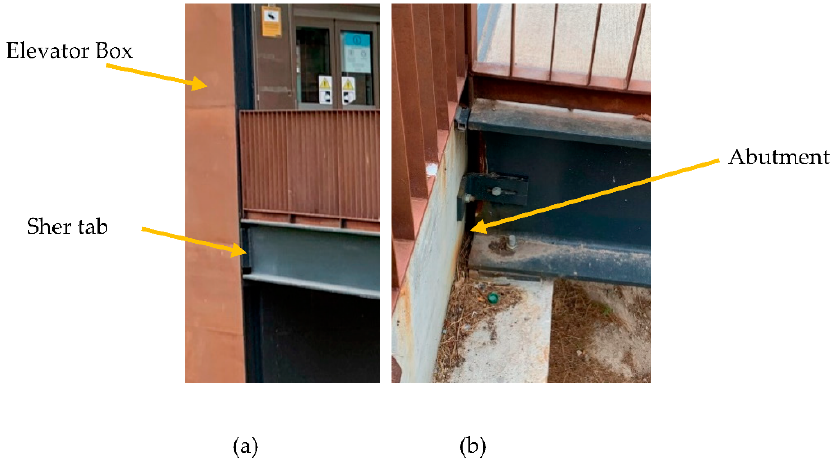
Figure 6. Supports of the footbridge bridge: ( a ) connection to the elevator and ( b ) abutment connection.